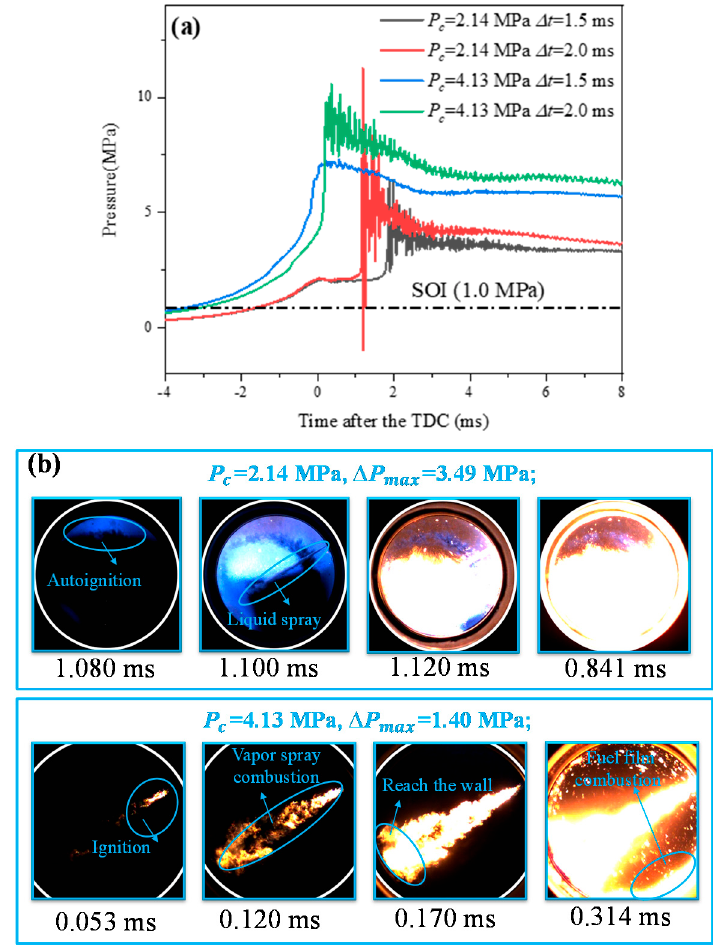
Figure 9. In-cylinder pressure and selected images of combustion evolution at FIP = 40 MPa: ( a ) In-cylinder pressure at FIP = 40 MPa; ( b ) Selected images of combustion evolution under the conditions of FIP = 40 MPa and ∆ t = 2.0 ms.